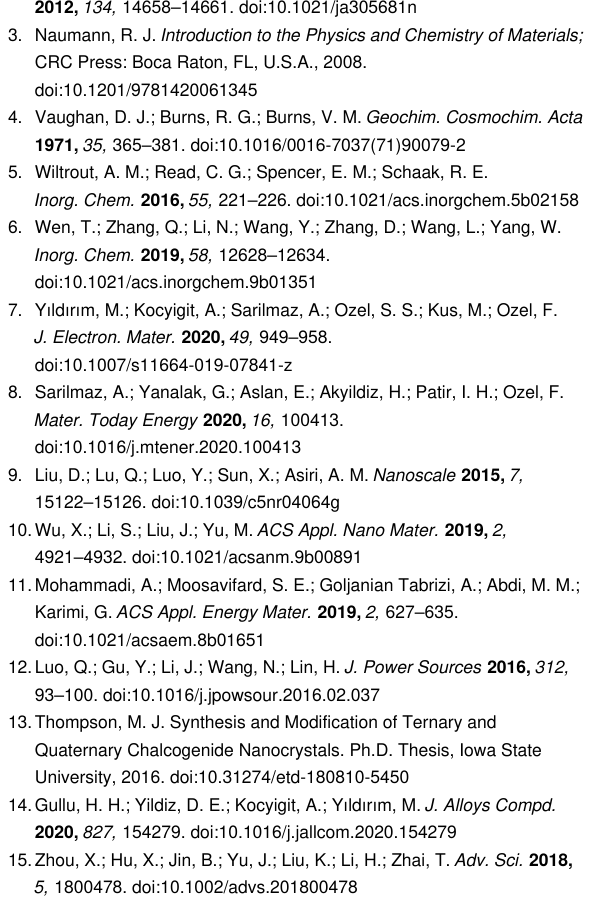
Figure 13: a) Photocurrent and b) photocapacitance changes of the Au/CuNiCoS 4 /p-Si photodiode under different power illumination densities.